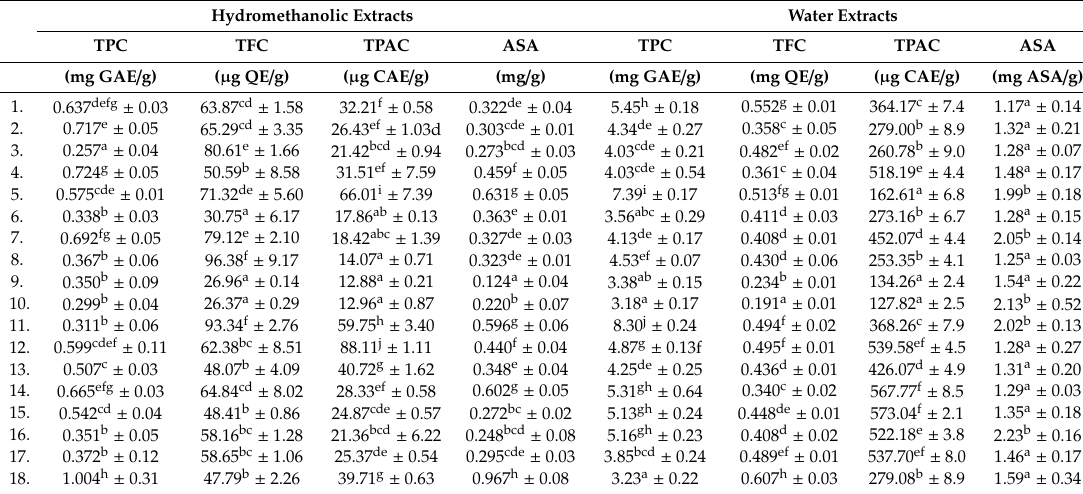
Table 2. Total phenolic (TPC), flavonoid (TFC), phenolic acids (TPAC) and ascorbic acid (ASA) contents in commercial samples of Morus alba L. (arithmetic mean ± standard